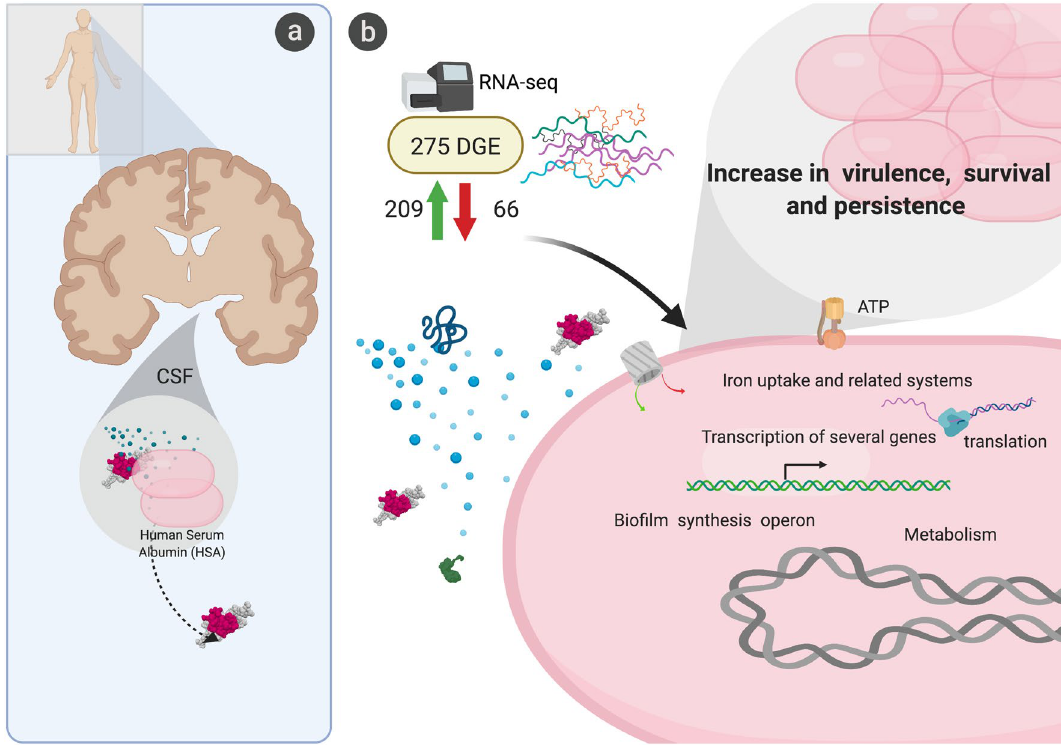
Figure 4. Graphical representation of A. baumannii’s transcriptomic and behavioral response to CSF. ( A ) General representation showing possible association of colonized A. baumannii in CSF towards HSA. ( B ) Hypothetical schematic showing possible role of HSA in inducing differential gene expression in A. baumannii. The differential expression of genes associated with metabolism, iron uptake systems, and translation machinery, among other, were found in the 275 DEGs. Created with